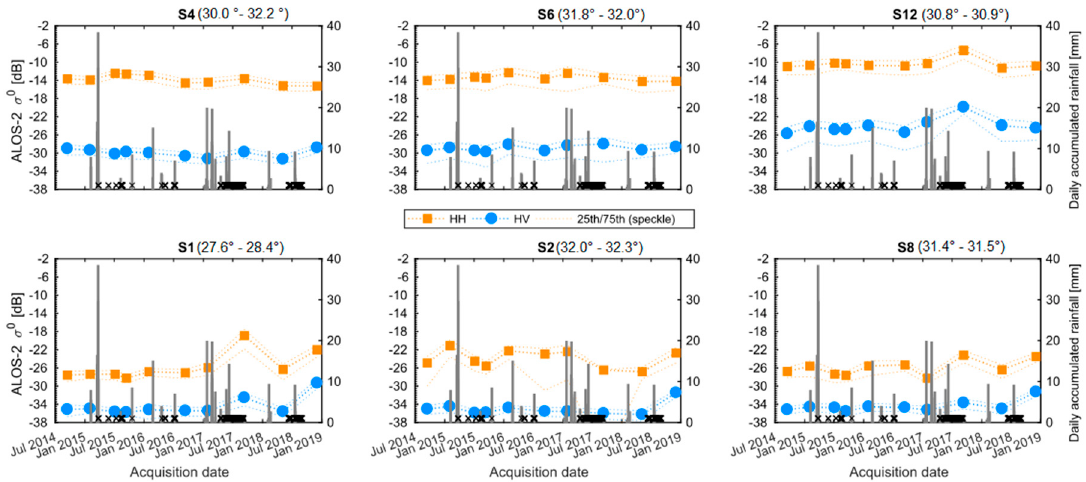
Figure 12. ALOS-2/PALSAR-2 temporal backscattering observed over the salt pan. Sites corresponded to Hard crust 2 (upper panel) and Soft crust (bottom panel). Ascending orbit. The local incidence angles are indicated in degrees. Daily accumulate rainfalls recorded at Socaire are in grey bars, and snowfall cover also shown as black crosses.